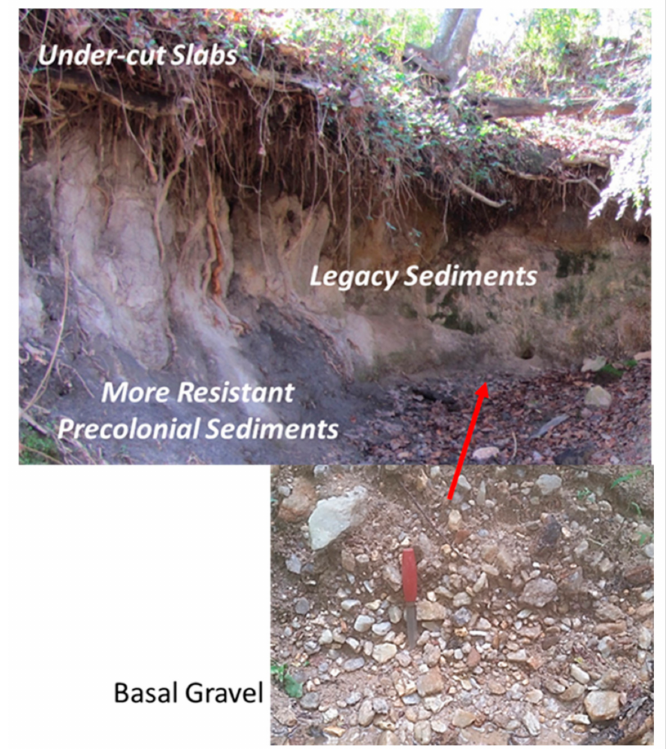
Figure 8. Commonly observed morphology of alluvial channel banks. Note undercut surface materials composed of legacy sediments and stabilized by roots. More resistant, dark colored precolonial sediments overlie alluvial gravels located at the base of the bank. Bank erosion occurs by combination of corrasion of fine particles creating an undercut section, and subsequent failure of slabs by cantilever mechanisms.